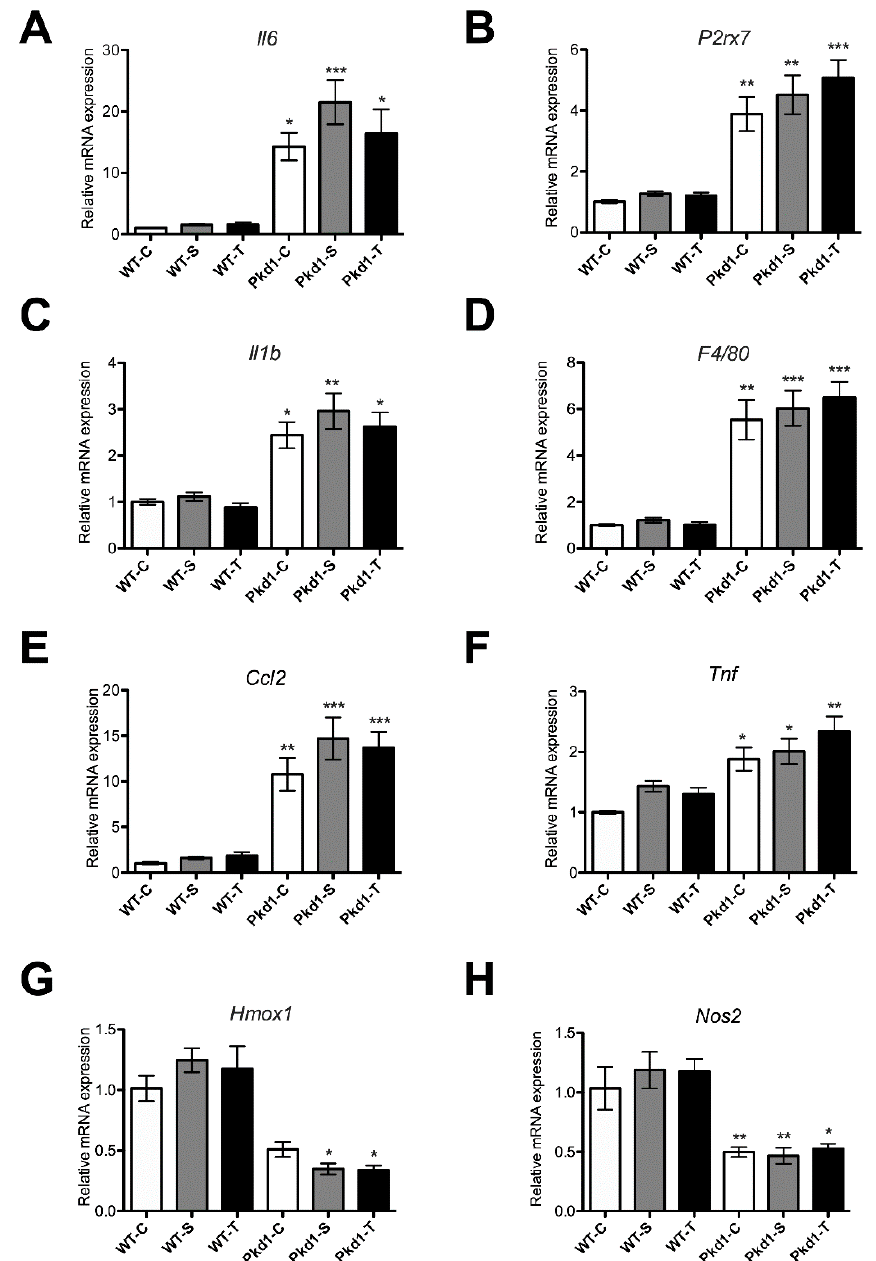
Figure 4. Trehalose treatment did not affect renal inflammation in Pkd1 miRNA transgenic mice. The renal mRNA expression levels of ( A ) Il6 , ( B ) P2rx7 , ( C ) Il1b , ( D ) F4/80 , ( E ) Ccl2 , ( F ) Tnf, ( G ) Hmox1, and ( H ) Nos2 in the different experimental groups of mice (n = 3, 6, 9, 9, 8, and 7 per group, respectively). * p < 0.05, ** p < 0.01, *** p < 0.001 compared with the wild-type control group. WT, wild-type; PKD, polycystic kidney disease; C, control; S, sucrose; T, trehalose .